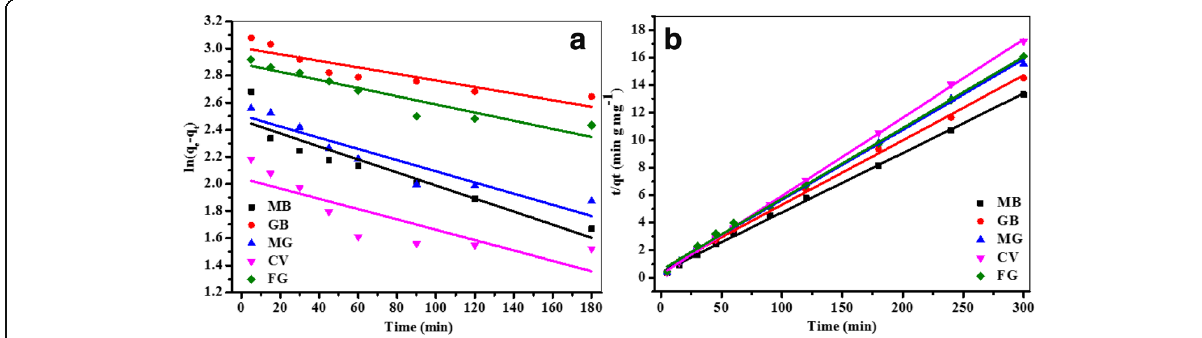
Fig. 4 Adsorption of cationic dyes on Fe 3 O 4 /PCC MNPs ( a ) pseudo-second-order kinetics ( b ) pseudo-first-order kinetics. As shown as Fig. 4, the blank line represent the adsorption of MB, the red line reperesent the adsorption of GB, the blue line represent the adsorption of MG, the magenta represent of CV adsorption, and the olive is on behalf of the adsorption of